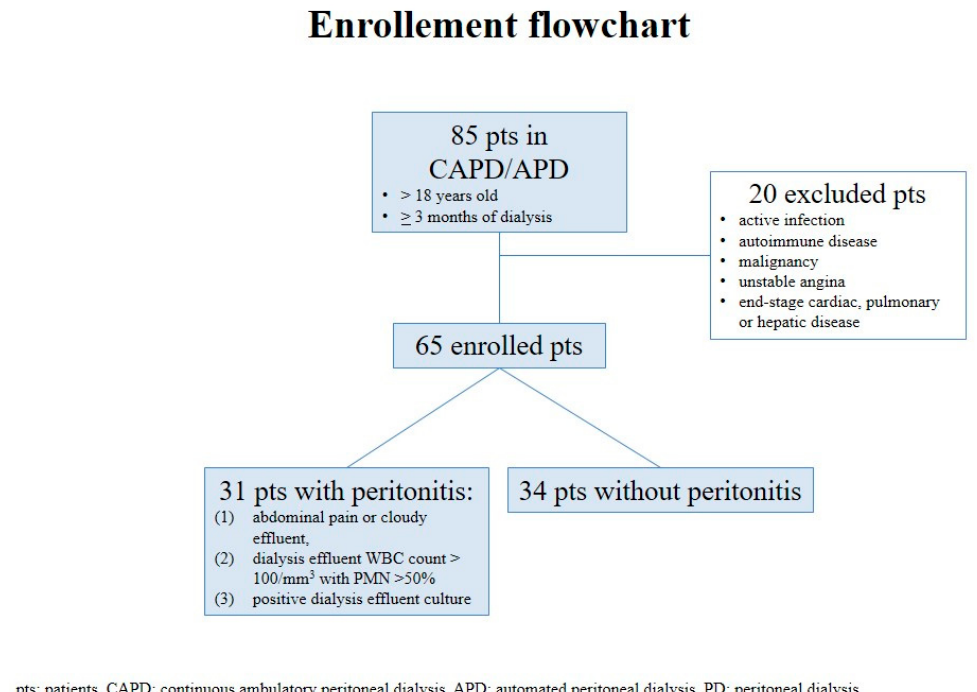
Figure 1. Enrollment flowchart of the study. WBC: white blood cell. PMN: Polymorphonuclear leukocytes.